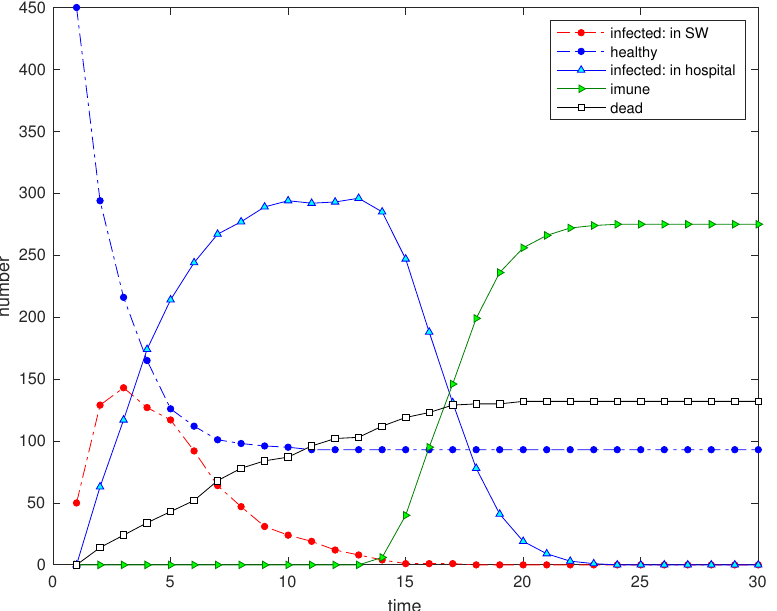
Figure 3. Scenario S 2 : Time evolution of the 5 state variables for α = 1 ( N = 500, n i = 50, D = 0.07, δ = 0.1, p 1 = 0.1, p 2 = 0.9, p 3 = 0.7, p 4 = 0.05, p 5 = 0.02 and N h → ∞ ).